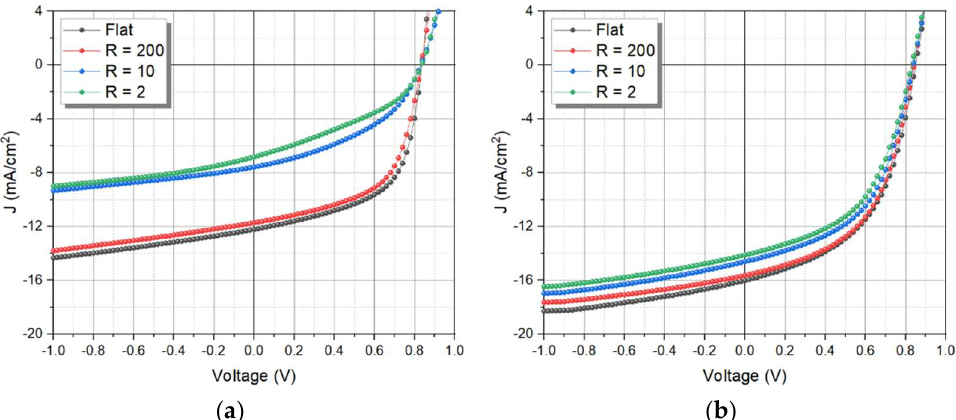
Figure 8. J–V characteristic of the detector according to bending curvature ( a ) with PBDB-T:PC 71 BM, and ( b ) PBDB-T:ITIC, fixed at 50 times bending cycle. Table 1. The parameters of detector without CsI(Tl) scintillator according to different acceptors (PC 71 BM and ITIC). Active